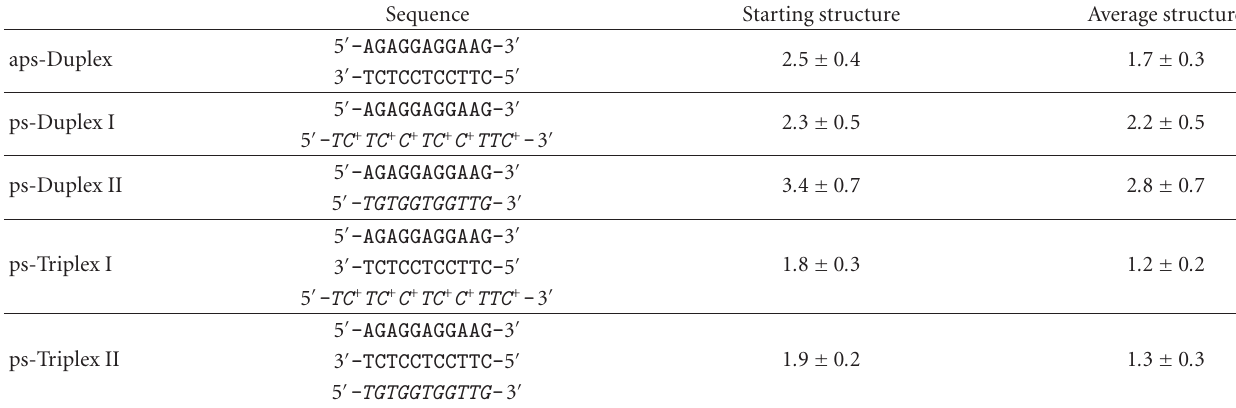
Table 3: Average root mean square deviation (RMSd in ˚A) between trajectories of the di ff erent duplexes and triplexes and the starting and average structures. The prefixes ps and aps refer to parallel and antiparallel topologies. Standard deviations in the averages are noticed in all